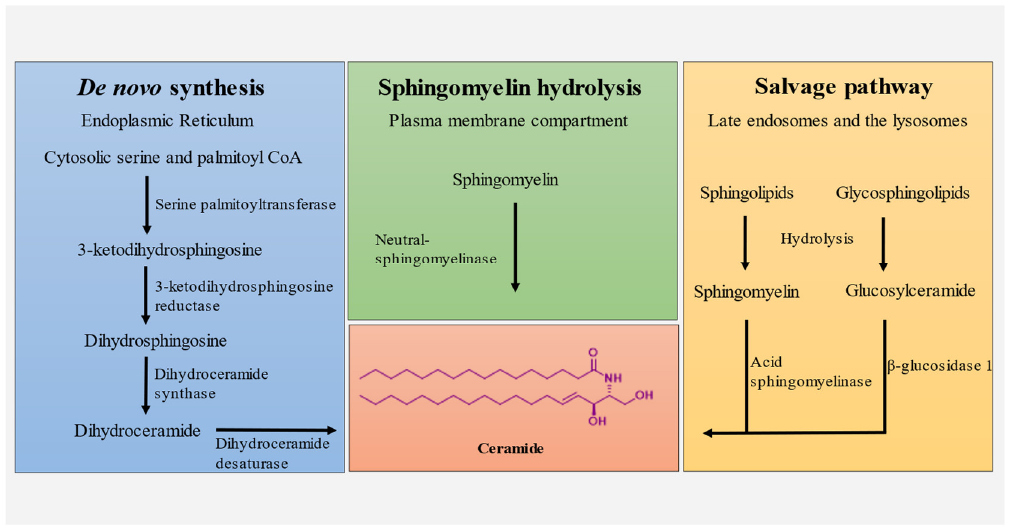
Figure 1. Ceramide synthesis pathways; de novo synthesis, sphingomyelin hydrolysis and salvage pathway.